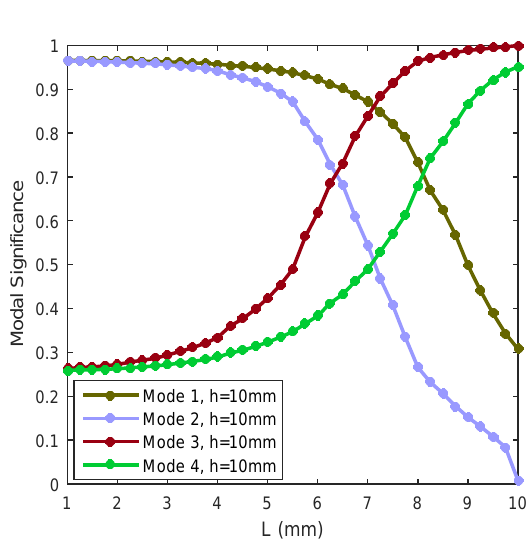
Figure 9: Ring-type reflectarray element in square-slot. (a) The geometry and mesh. (b) The reflection